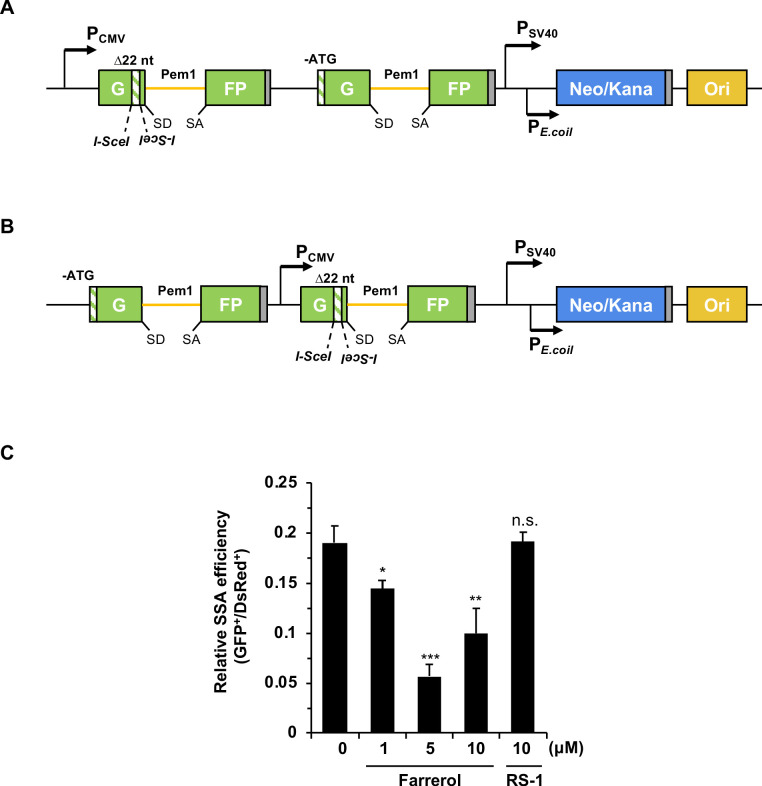
Farrerol inhibits the SSA efficiency.(A) Schematic diagram of reporter cassette HRF measuring gene conversion, crossing over, and SSA. The cassette contains two copies of defective GFP-Pem1. The first copy has two inverted I-SceI recognition sites, and a 22-nt deletion on the first exon of GFP, and the second copy of GFP lacks the start codon. I-SceI induced DSBs can be repaired by gene conversion, crossing over or SSA, resulting in functional GFP. SD, splice donor; SA, splice acceptor; the yellow line stands for the homologous arm. (B) Schematic diagram of reporter cassette HRIF measuring gene conversion and crossing over. The positions of the two copies of defective GFP is different in HRF and HRIF. In HRF reporter, both copies are downstream CMV promoter while in HRIF reporter the CMV promoter is located between the two copies of GFP. In response to I-SceI digestion, only gene conversion or crossing over can reconstitute functional GFP. SD, splice donor; SA, splice acceptor; the yellow line stands for the homologous arm. (C) Effect of farrerol and RS-1 treatment on SSA efficiency. The two reporters were integrated into HCA2-hTERT cells, and a pool of colonies containing chromosomally integrated reporters were mixed for further analysis. HRF minus HRIF was employed as the measure of SSA efficiency. 5 μg I-SceI vector and 15 ng pDsRed2-N1 were transfected into reporter cells pre-treated with different small molecules. Small molecules were still added to the cells until FACS analysis three days after transfection. The ratio of GFP positive cells versus DsRed positive cells was used as the measure of repair efficiency. Error bars represent the s.d. *p<0.05, **p<0.01, ***p<0.001, n.s., not significant, t-test. All experiments were repeated at least three times.